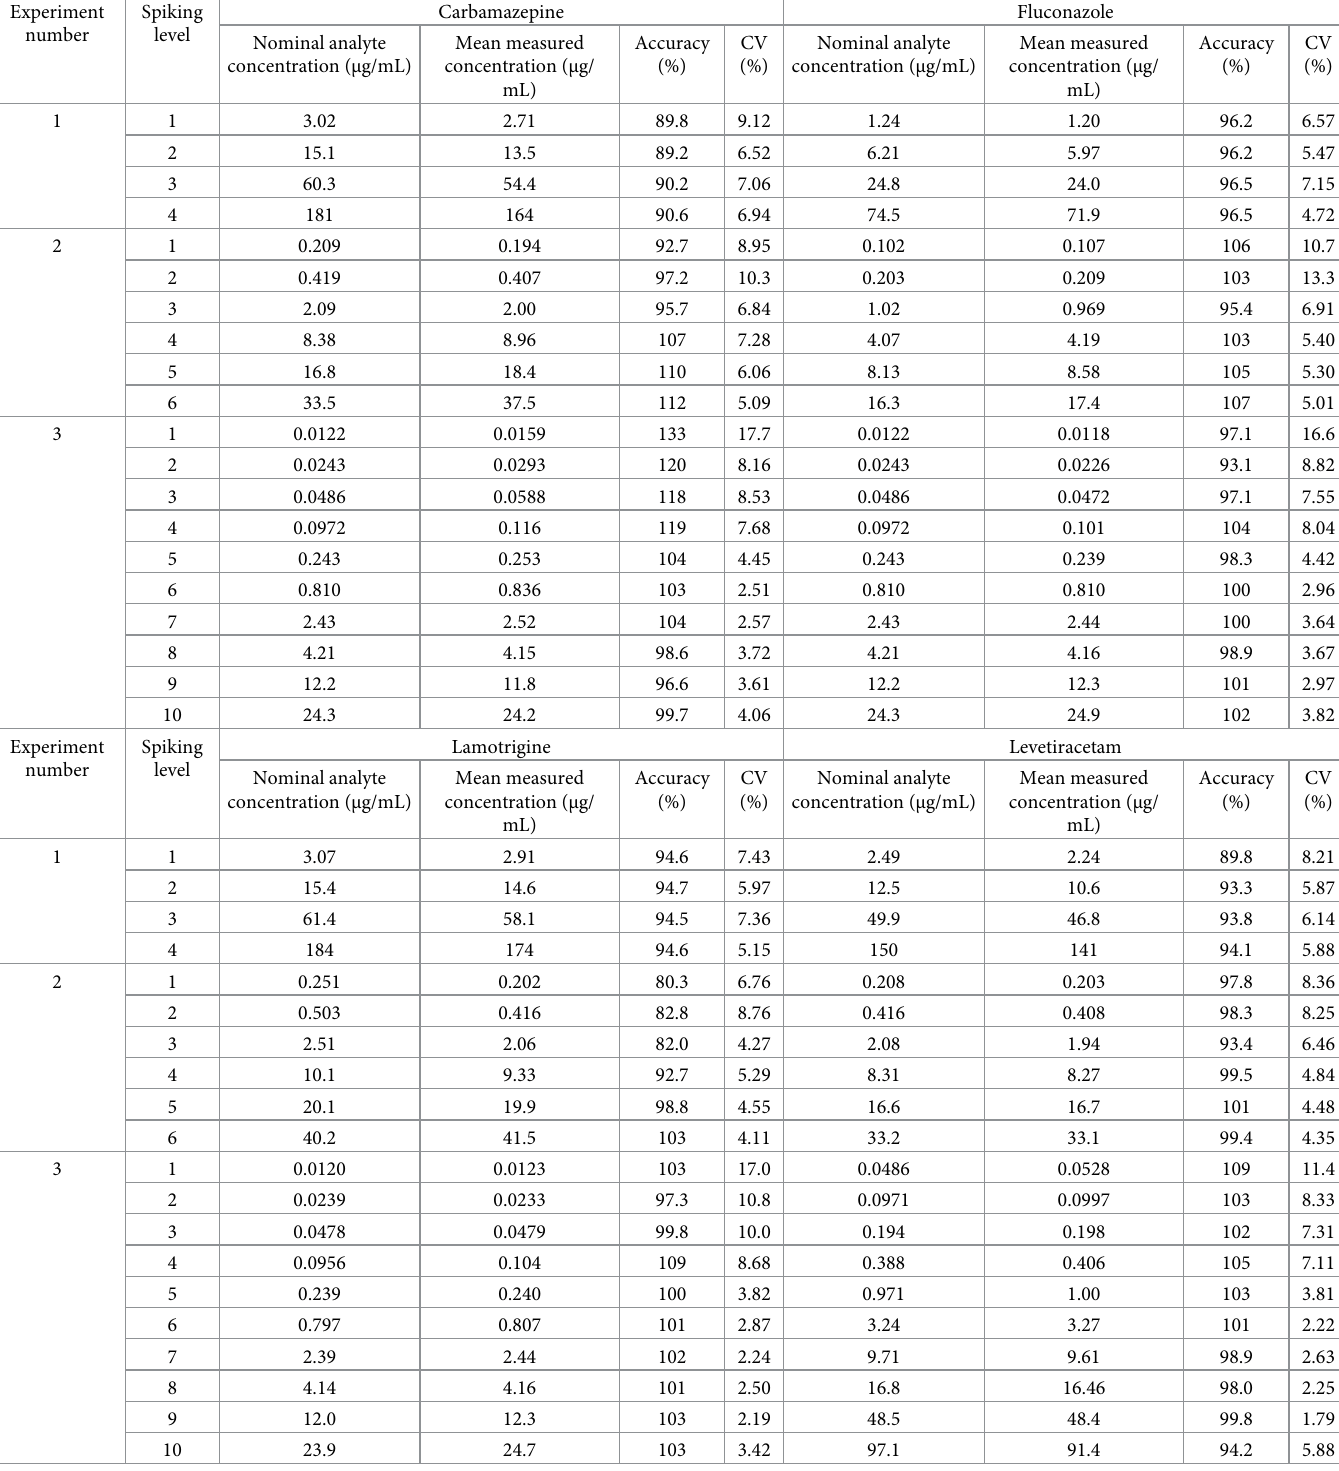
Table 3. Within-run accuracy and relative precision (expressed as the coefficient of variation) obtained for the analytes in spiked independent serum samples in the conducted experiments. Experiment